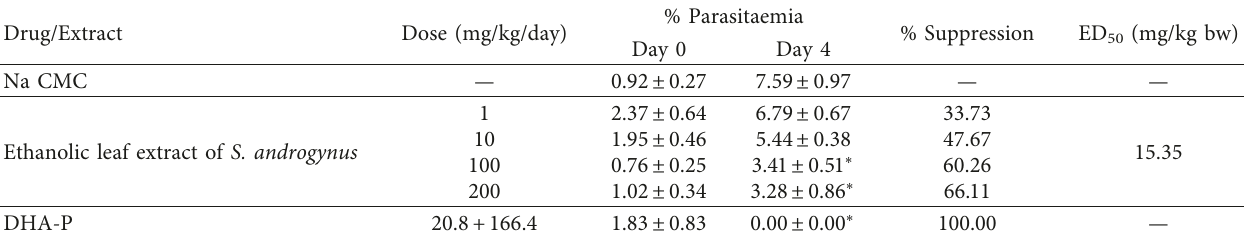
Ethanolic leaf extract of S. androgynus DHA-P